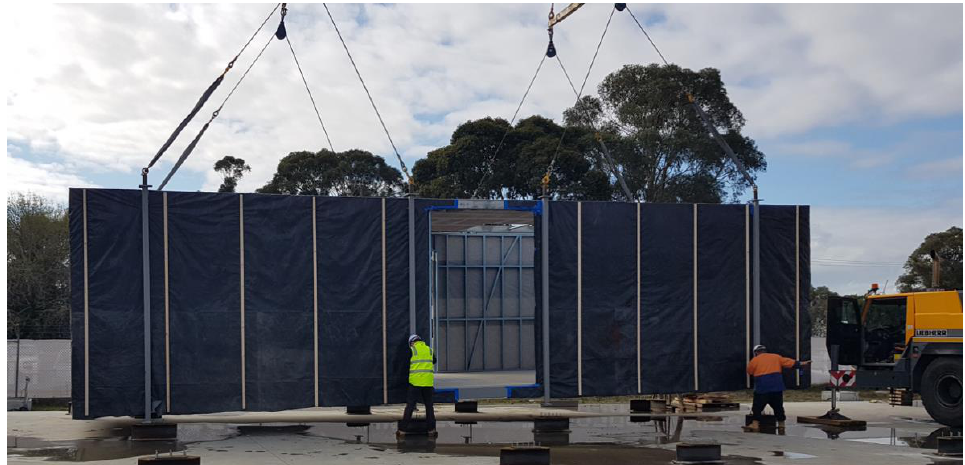
Figure 7. A partly finished structural module being lifted into place using a top-lift method where the lifting mechanism is properly connected to full-length structural columns.